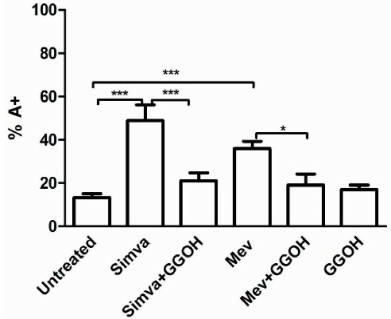
Figure 2. Daoy cell line was incubated with Mevalonate (10 mM) and/or Simvastatin (10 µ M) for 24 h and with GGOH (50 µ M) for an additional 24 h. Programmed Cell Death is expressed as percentage of Annexin V positive cells (%A+) and bars represent the means % ˘ SD of five independent experiments. Data analyses were performed with one-way ANOVA followed by Bonferroni post-test; * p < 0.05; ** p < 0.01, *** p <